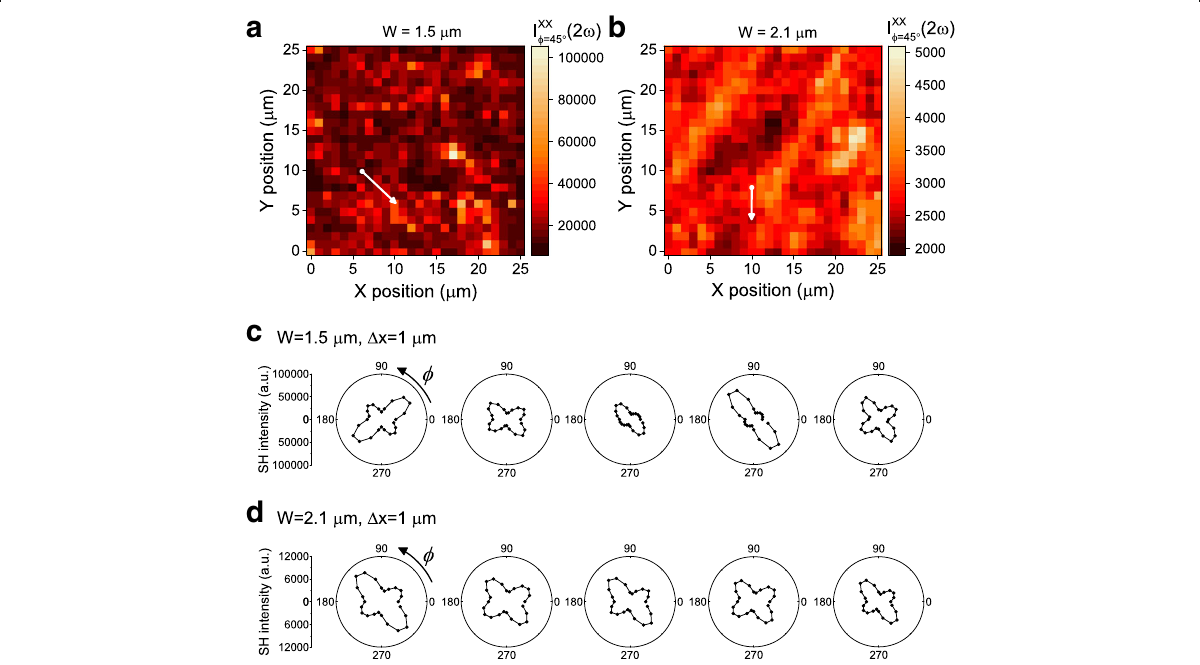
Fig. 3 Second harmonic generation (SHG) results obtained with beam sizes of 1.5 and 2.1 μ m. a , b The SHG intensity mapping image obtained with beam sizes of 1.5 and 2.1 μ m, respectively. c , d Azimuth-dependent polar plots of the SHG intensity obtained at different sample positions with beam sizes of 1.5 and 2.1 μ m, respectively, along the arrows in each